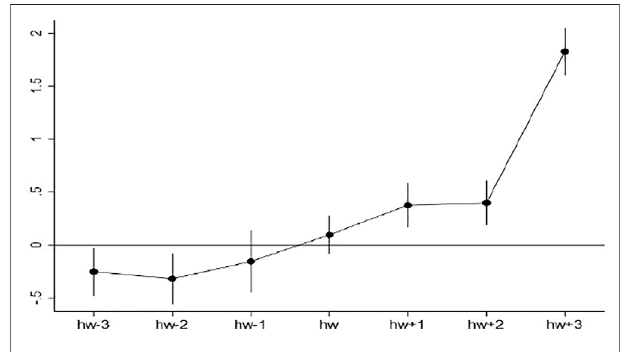
FIGURE 1 | Parallel trend test.